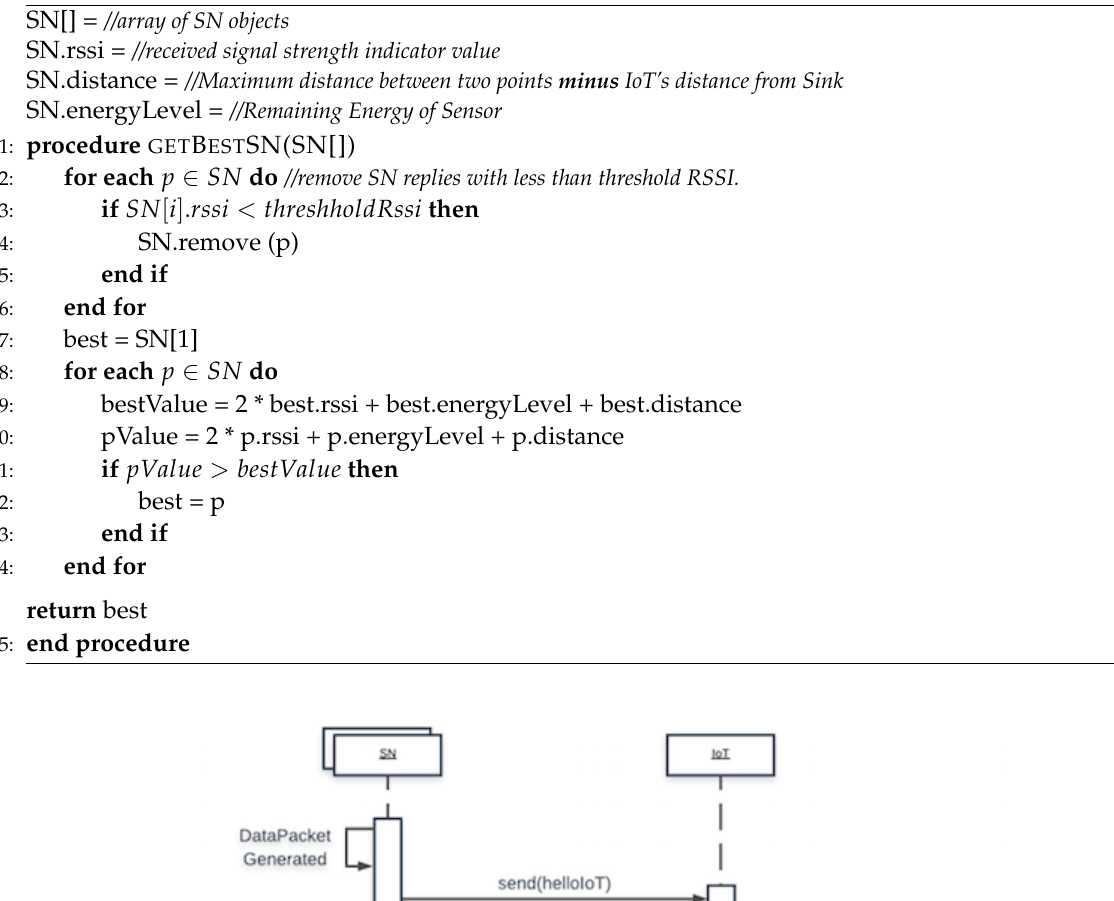
Algorithm 2 getBestSN